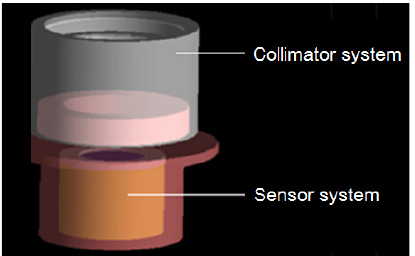
Figure 4. Schematic diagram of the high-energy particle probe structure.